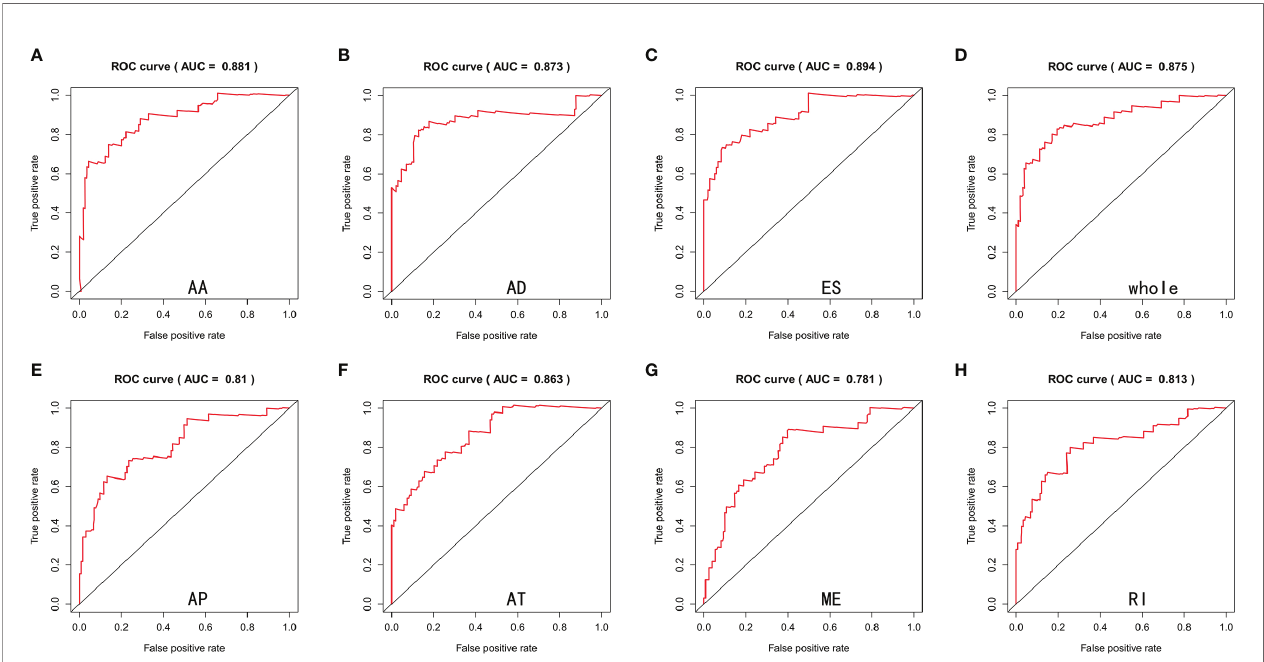
FIGURE 5 | ROC curves estimated the predictive power of AA (A) , AD (B) , ES (C) , whole (D) , AP (E) , AT (F) , ME (G) and RI (H) type of prognostic